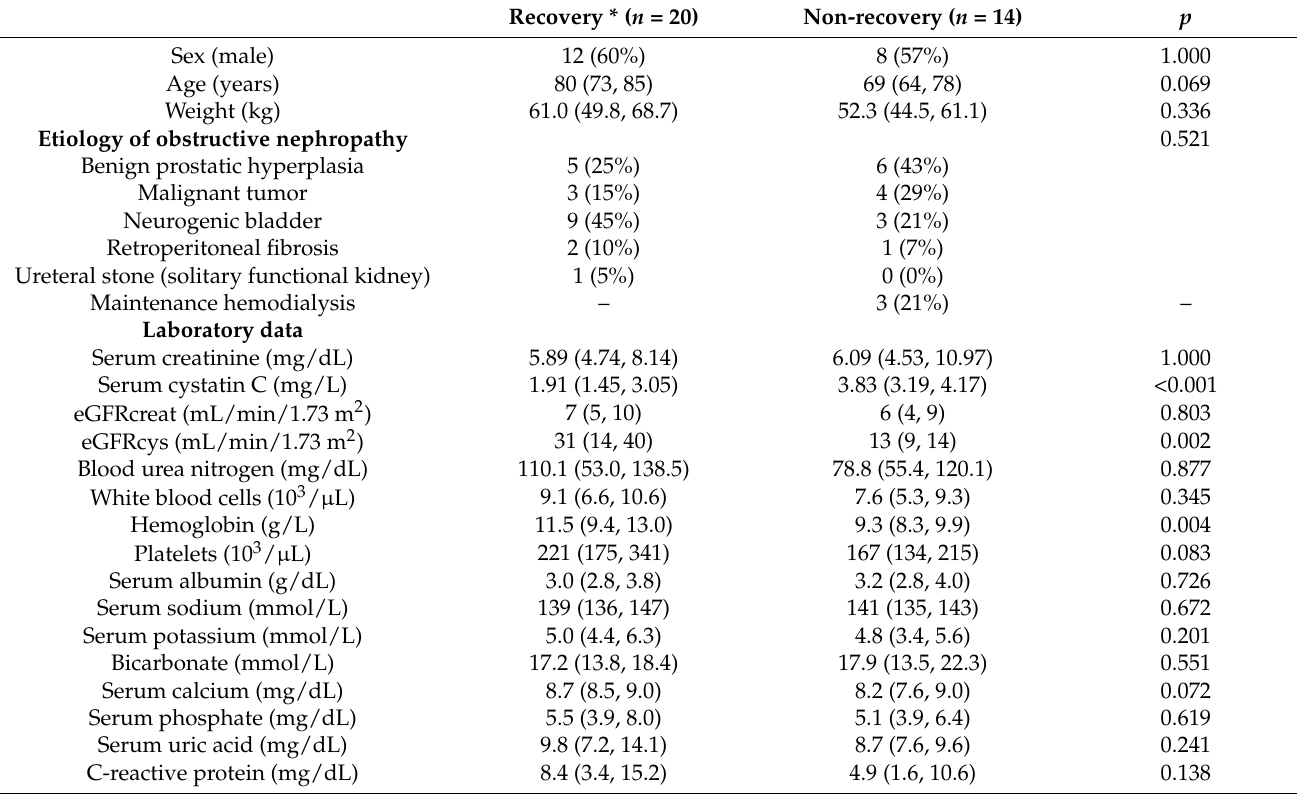
Table 2. Baseline clinical findings of the recovery and non-recovery